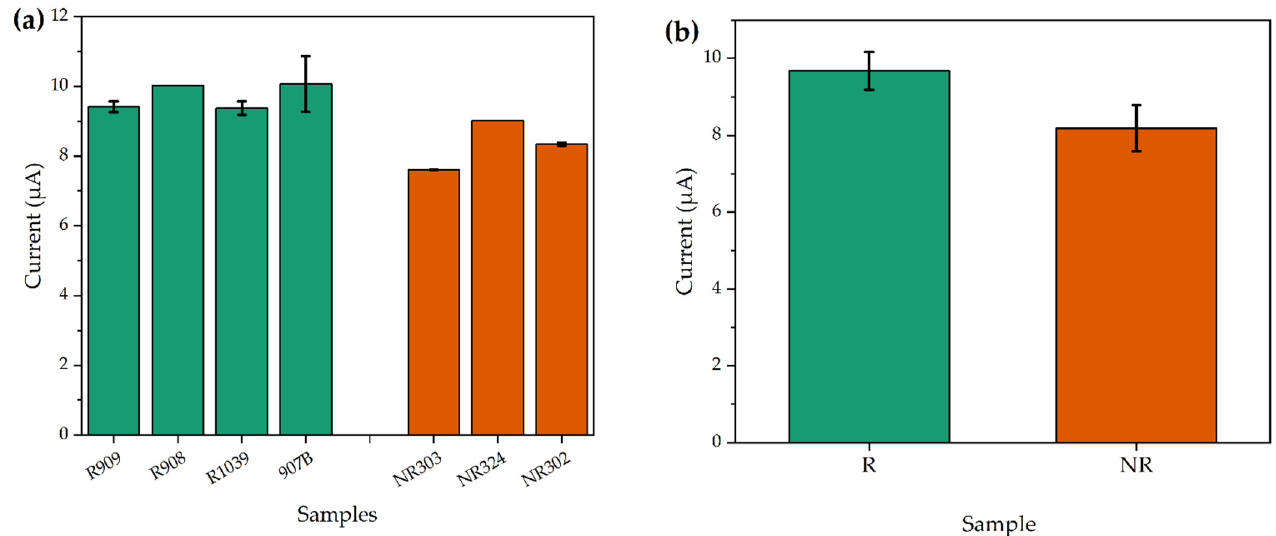
Figure 8. Cyclic voltammetry measurements of immunosensors for reactive and non-reactive clinical samples performed in the portable potentiostat. ( a ) Oxidation current values for R and NR samples and ( b ) final mean analyses of clinical specimens.